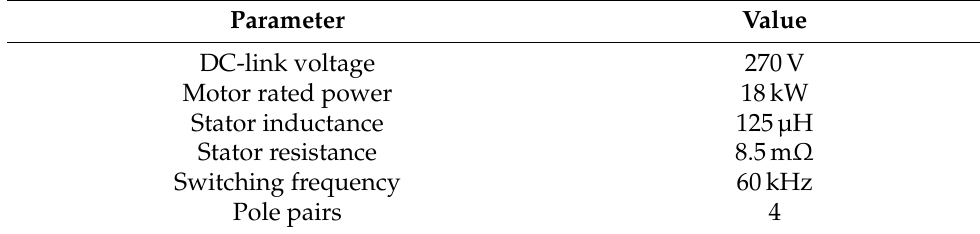
Table 1. Parameters of the studied